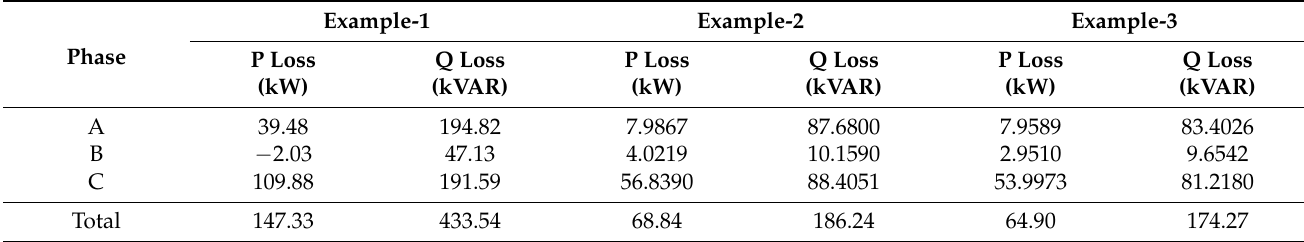
Table 7. Power loss comparison for different study examples of the IEEE-13 bus URDN.